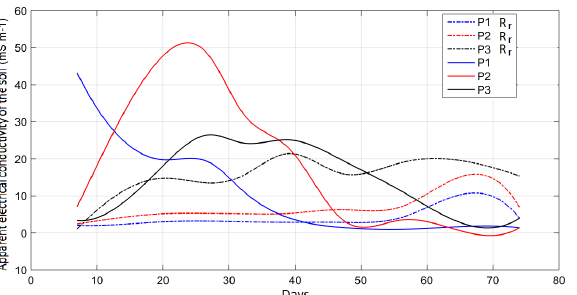
days of cultivation for data collected in the ×